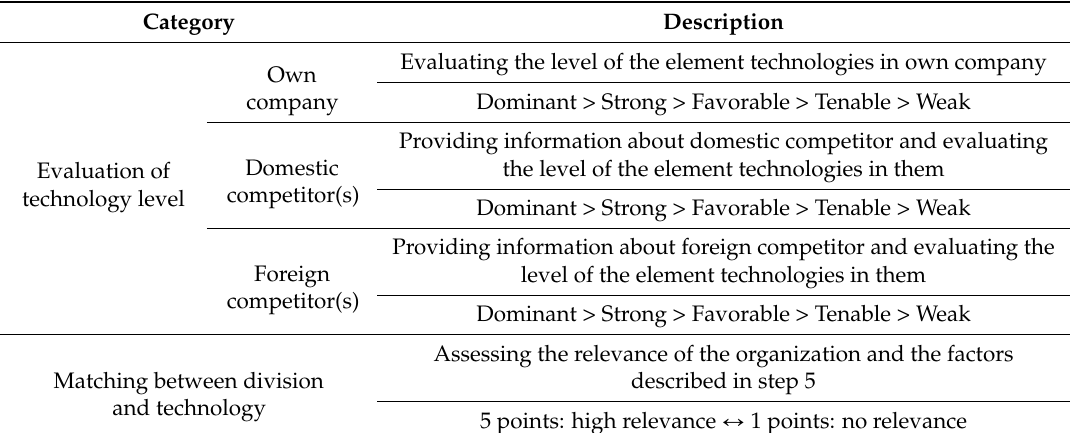
Table 4. Evaluation items for technology level